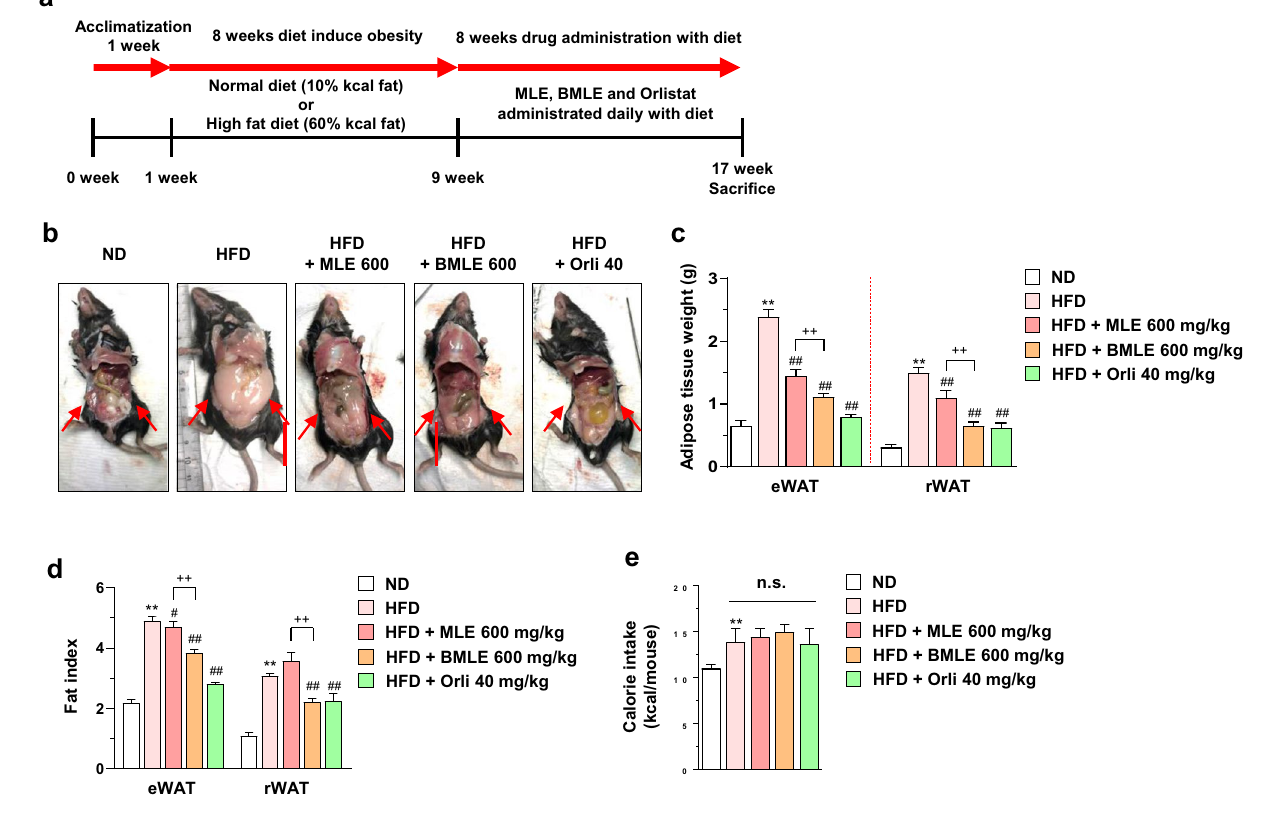
Figure 2. Effects of mulberry leaf extract (MLE) and bioconverted mulberry leaf extract with Pectinex (BMLE) on adipose fat mass in high-fat diet (HFD)-induced obese mice. ( a ) Schematic chart for animal study design. ( b ) Effects of MLE (600 mg/kg) and BMLE (600 mg/kg) administration on HFD-induced adipose tissue mass (n = 6 per group). Normal diet (ND)-fed mice were used as a negative control for high-fat diet-induced fat accumulation, and orlistat (40 mg/kg, orli) was used as a positive control for anti-obesity effects. ( c ) Effects of MLE and BMLE on HFD-induced epididymal adipose tissue (eWAT) and retroperitoneal white adipose tissue (rWAT) mass (n = 6 per group). ( d ) Effect of MLE and BMLE on fat index in HFD-induced mice (n = 6 per group). ( e ) Effects of MLE and BMLE on calorie intake. Fat index and calorie intake was calculated as described in the Materials and methods section. ** P < 0.01 vs. ND-fed mice or each group, # P < 0.05 vs. HFD-fed mice, ## P < 0.01 vs. HFD-fed mice, ++ P < 0.01 vs. each group, n.s.; not significant. Data are presented as the mean ±